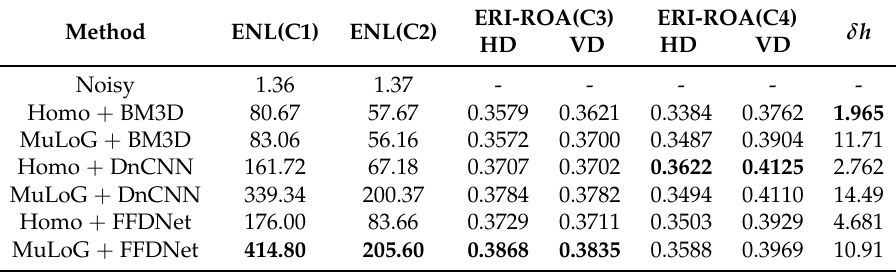
Table 4. The quantitative comparison of different methods for real SAR image: Data